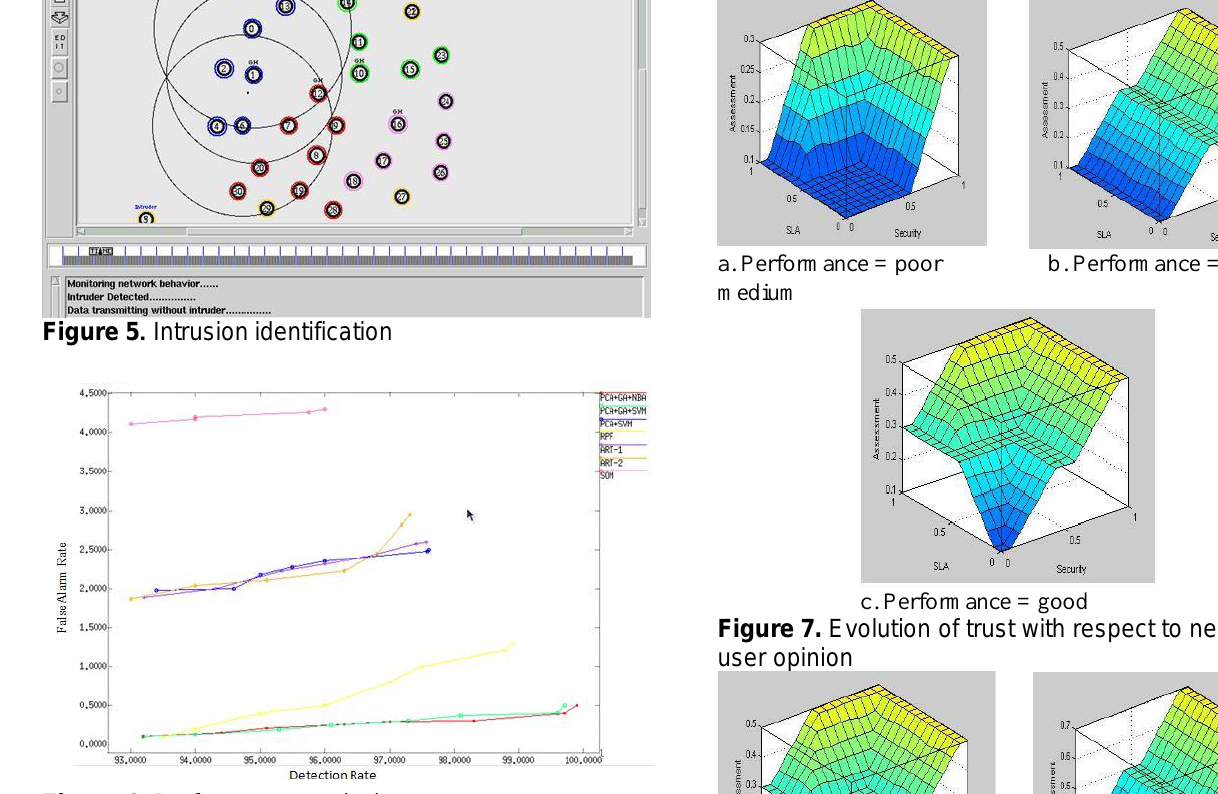
Figure 6 . Performance analysis